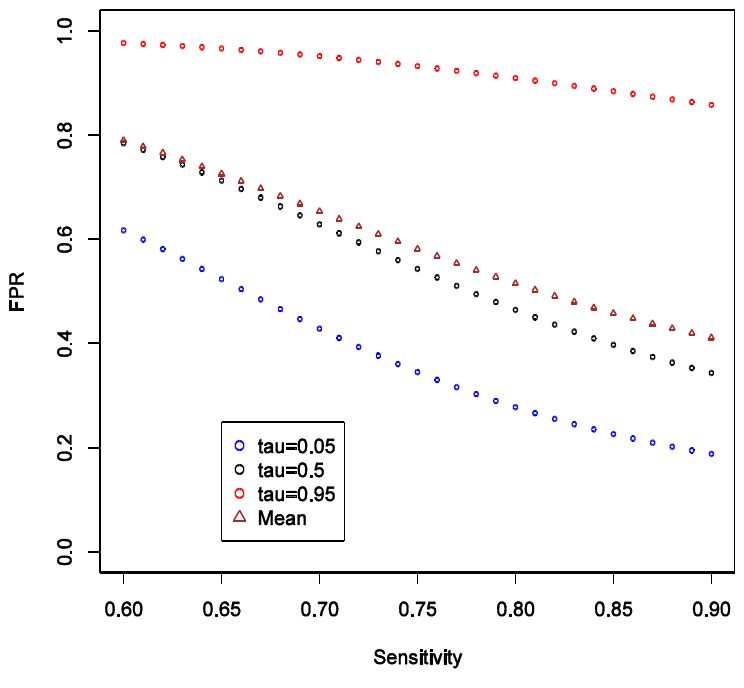
Figure 7. Theoretical calculations of the impact of varying sensitivity of exposure classifier while keeping specificity fixed at 0.5; tau (τ) = expected quintiles of the distribution for false positive rate (FPR); see text for details of other parameter settings.